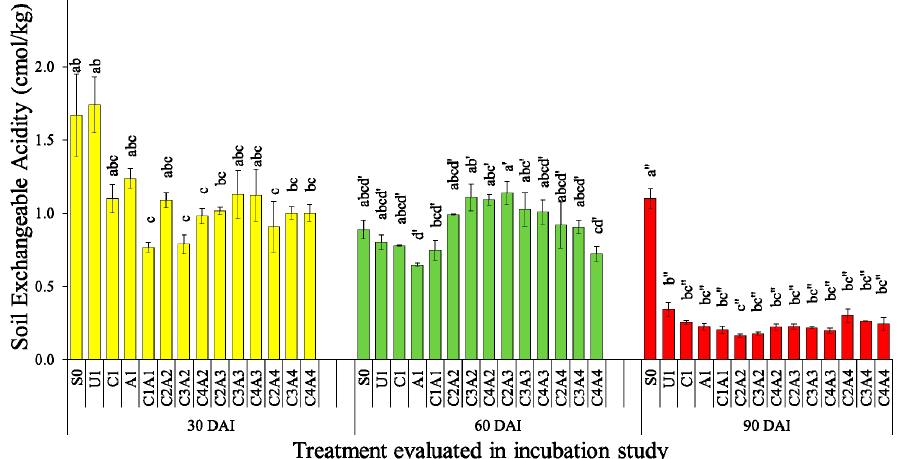
Figure 4. Treatments on soil exchangeable acidity after thirty, sixty, and ninety days of incubation. Means with different letter(s) within the same incubation period indicate significant difference between treatments by Tukey’s HSD test at p ≤ 0.05. Bars represent the mean values ± SE.